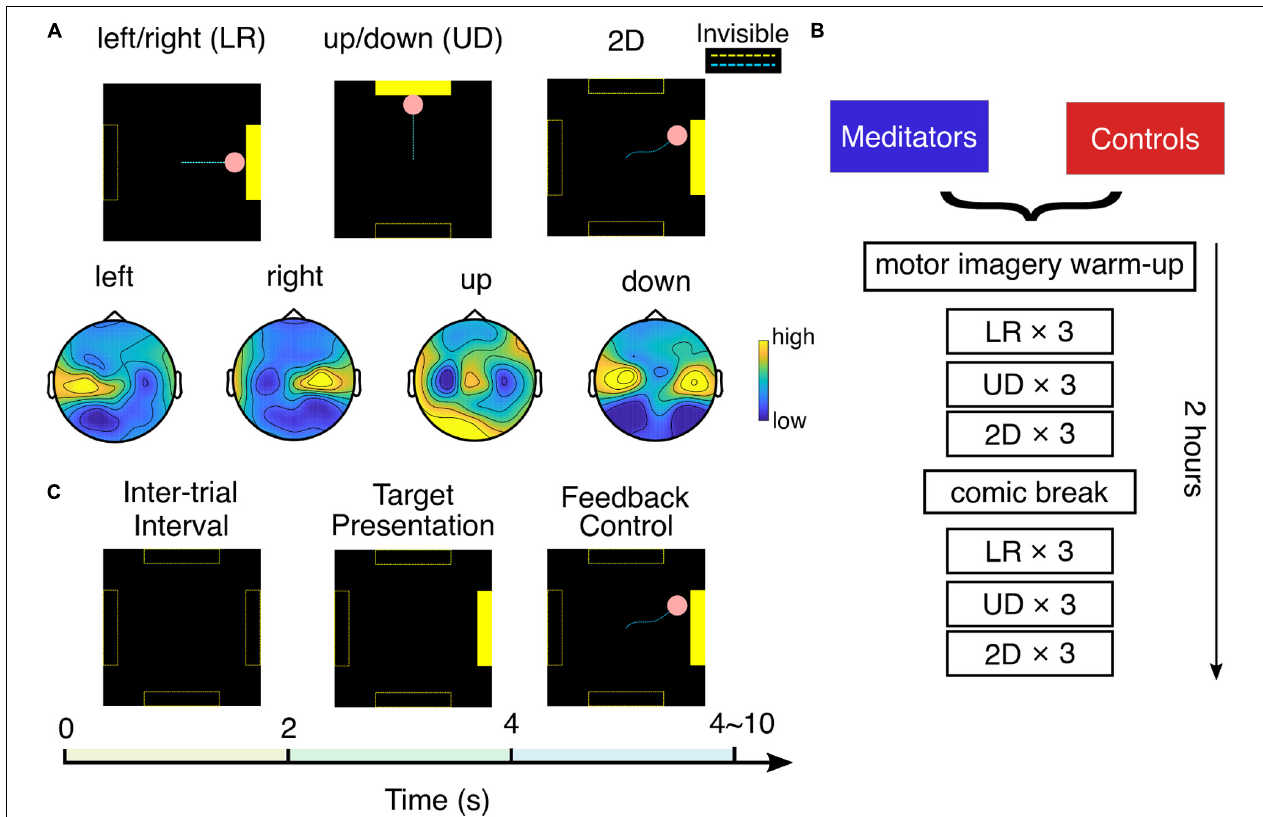
FIGURE 1 | Experimental setup. (A) Top: three experiment tasks and typical cursor trajectories in left/right (LR) control, up/down (UD) control, and 2D control. Dashed lines were invisible to the subject. Bottom: example topology of mu rhythm band power in each motor imagery class. (B) Experiment flow of one session. (C) Each trial consists of 2 s of intertrial interval, 2 s of target presentation, and 0–6 s of BCI feedback control.